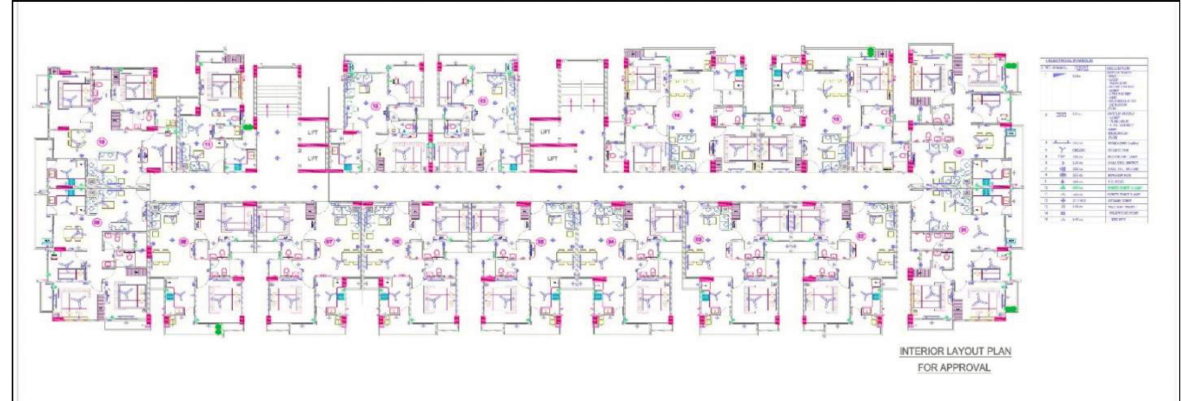
Figure 2: Floor plan.